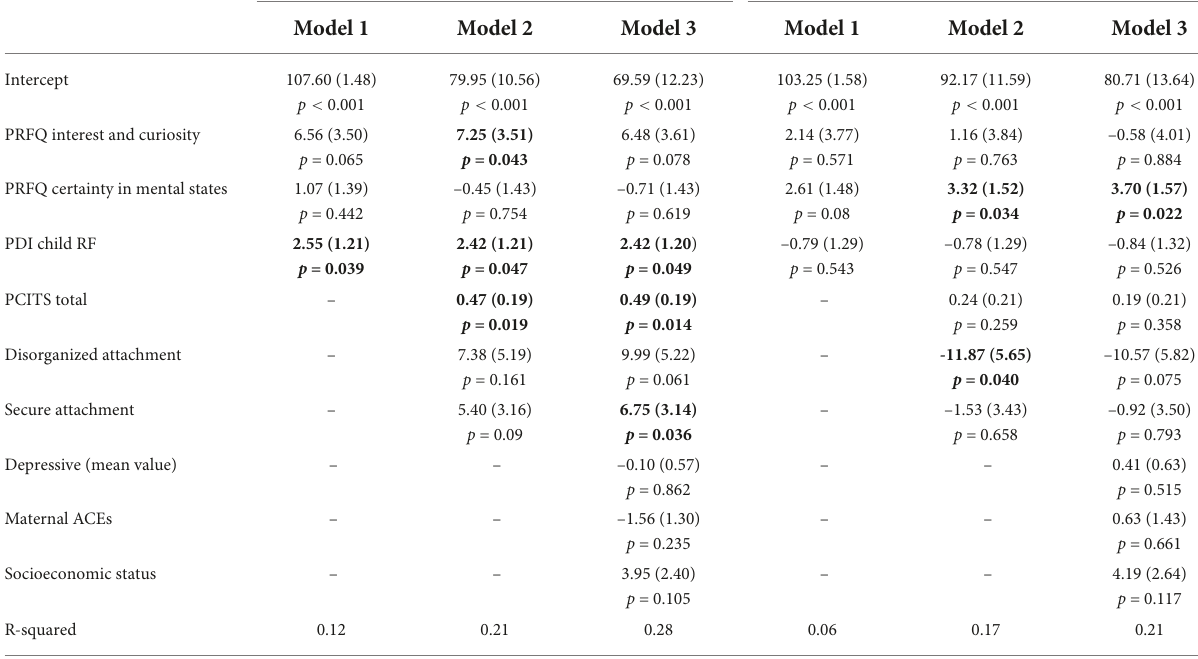
TABLE 3 Verbal comprehension and working memory stepwise linear